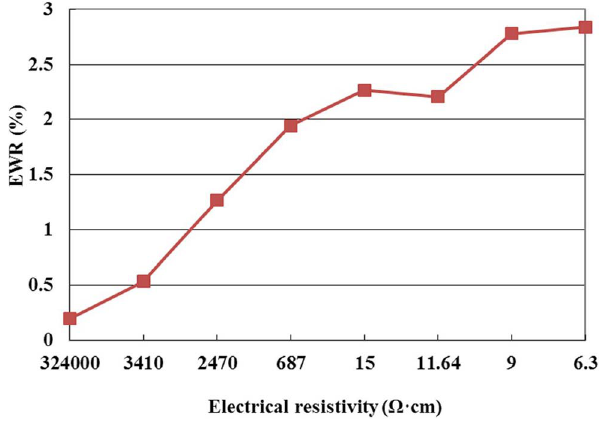
Figure 5. Effect of the tool polarity on MRR.